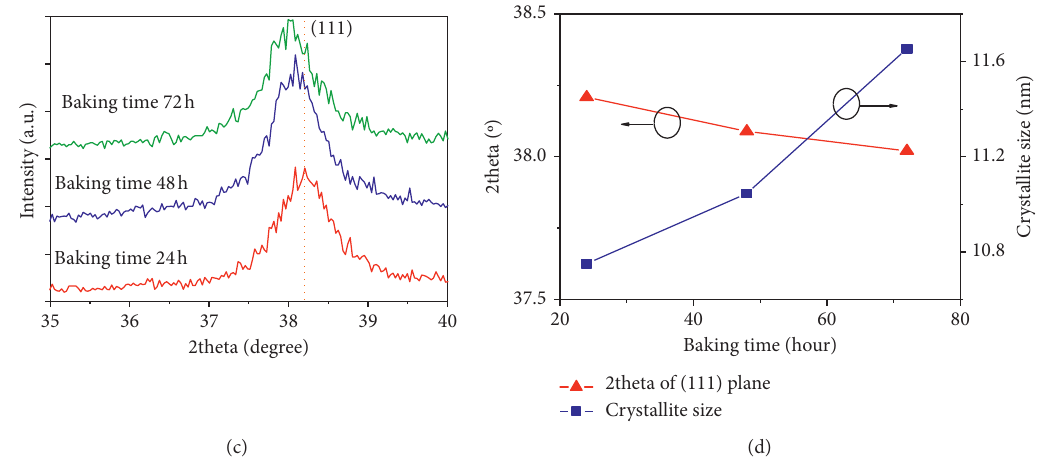
Figure 3: (a) The XRD pattern of Ag NP powders; (b) XRD pattern of the sample baking for 24h in comparison with the standard pattern of the silver (ICSD 98-018-0878) and silver oxide AgO (ICSD 00-003-5662); (c) the XRD patterns of samples focusing on the peak (111) of Ag; (d) the variation of position of the diffraction peak of the (111) plane and the crystallite size of Ag with baking